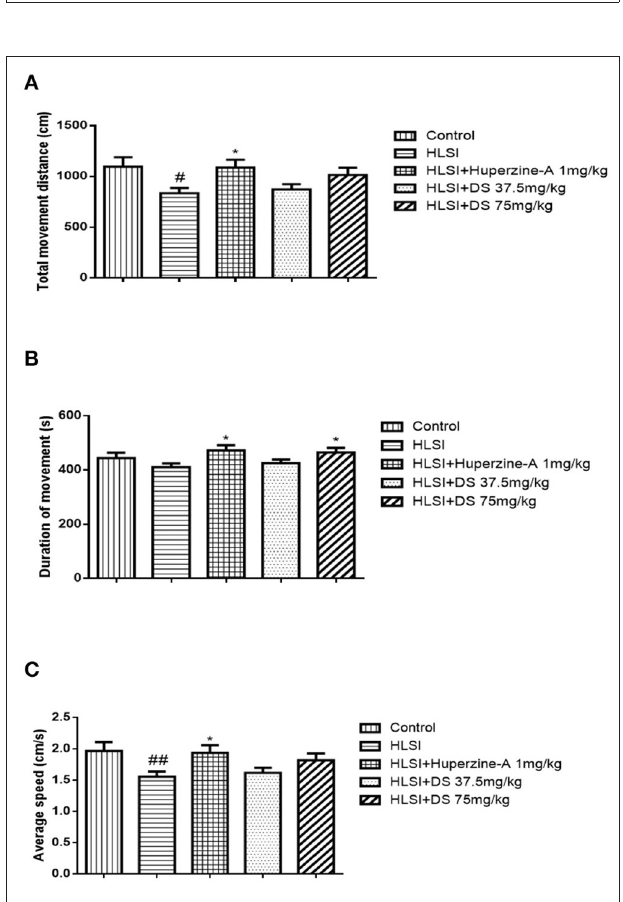
FIGURE 4 | The effects of DS on the locomotor activity in the open-field test after HLSI in rats. The values are mean ± SEM ( n = 8–9) for the following: (A) total movement distance, (B) duration of movement, and (C) average speed. The symbols represent: # p < 0.05 and ## p < 0.01 as compared with the control group; * p < 0.05 as compared with the HLSI group.